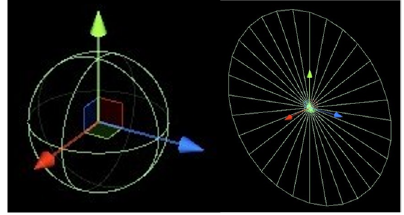
R of the current L of the feature seg- j